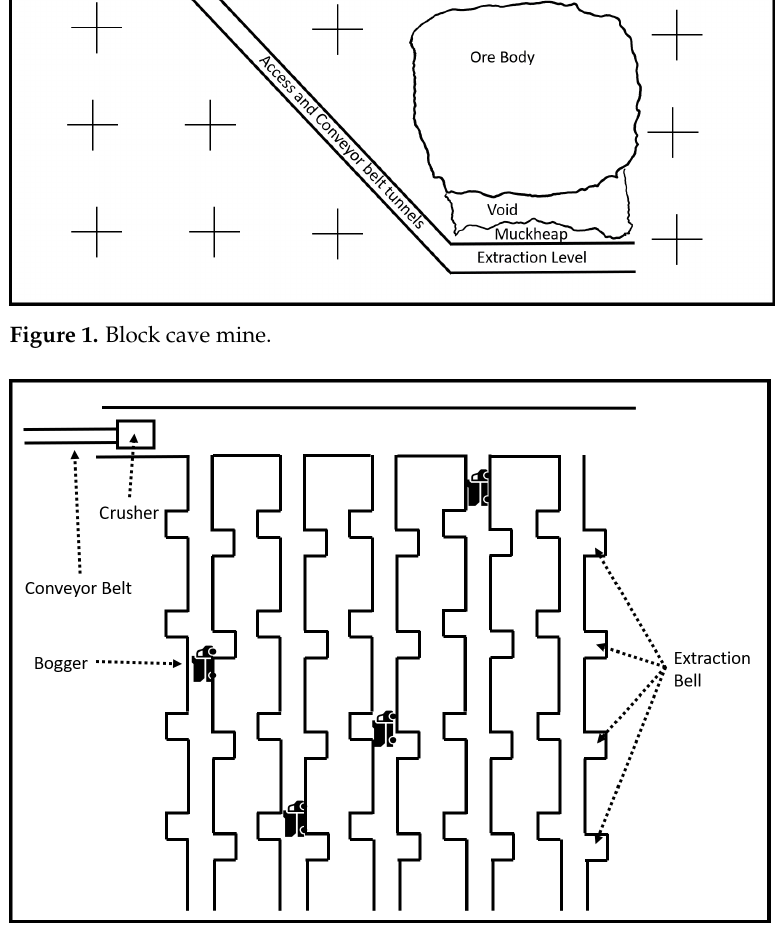
Figure 2. Extraction